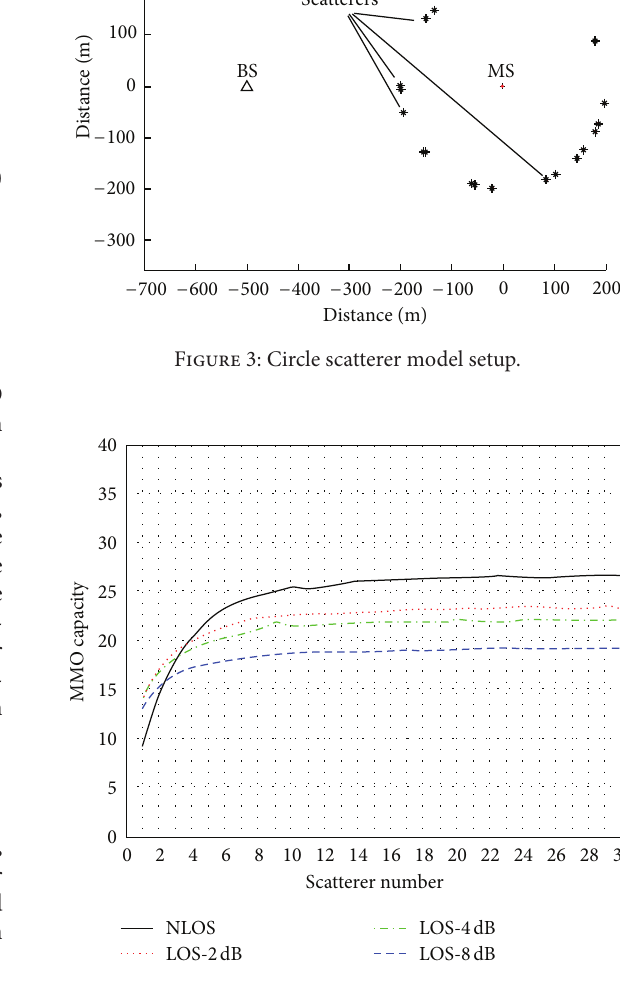
F 4: MIMO capacity